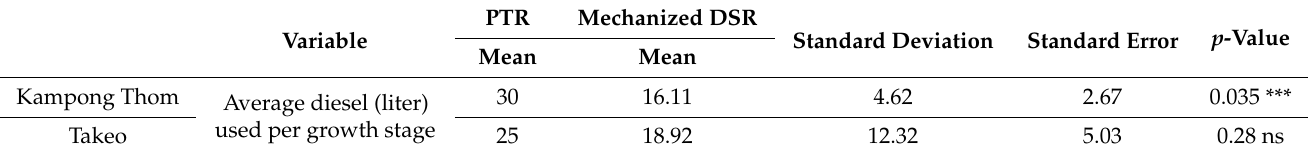
Table 3. Energy saving under mechanized DSR compared to PTR at Kampong Thom and Takeo sites, Cambodia. PTR Mechanized Variable